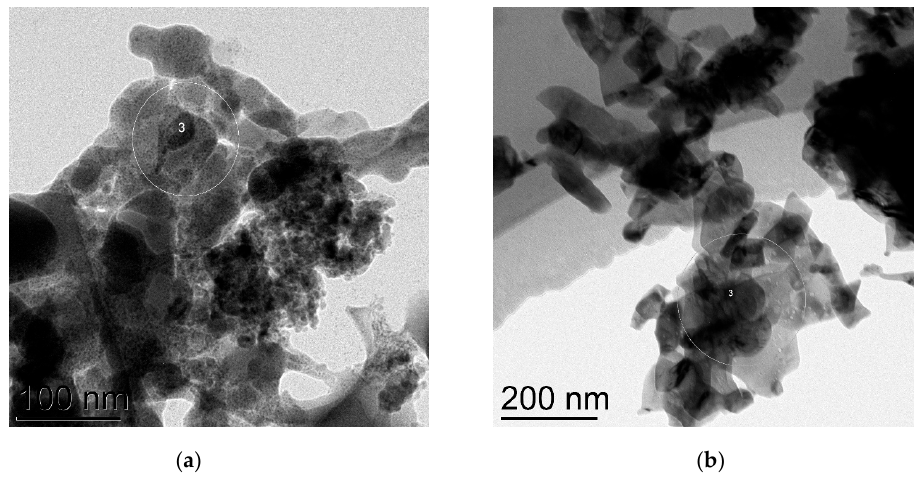
Figure 7. TEM images of the copper nanocatalysts after the amination reaction: ( a ) initial CuNPs 25 nm converted into CuO NPs; ( b ) initial CuNPs 10/80 nm converted into CuO